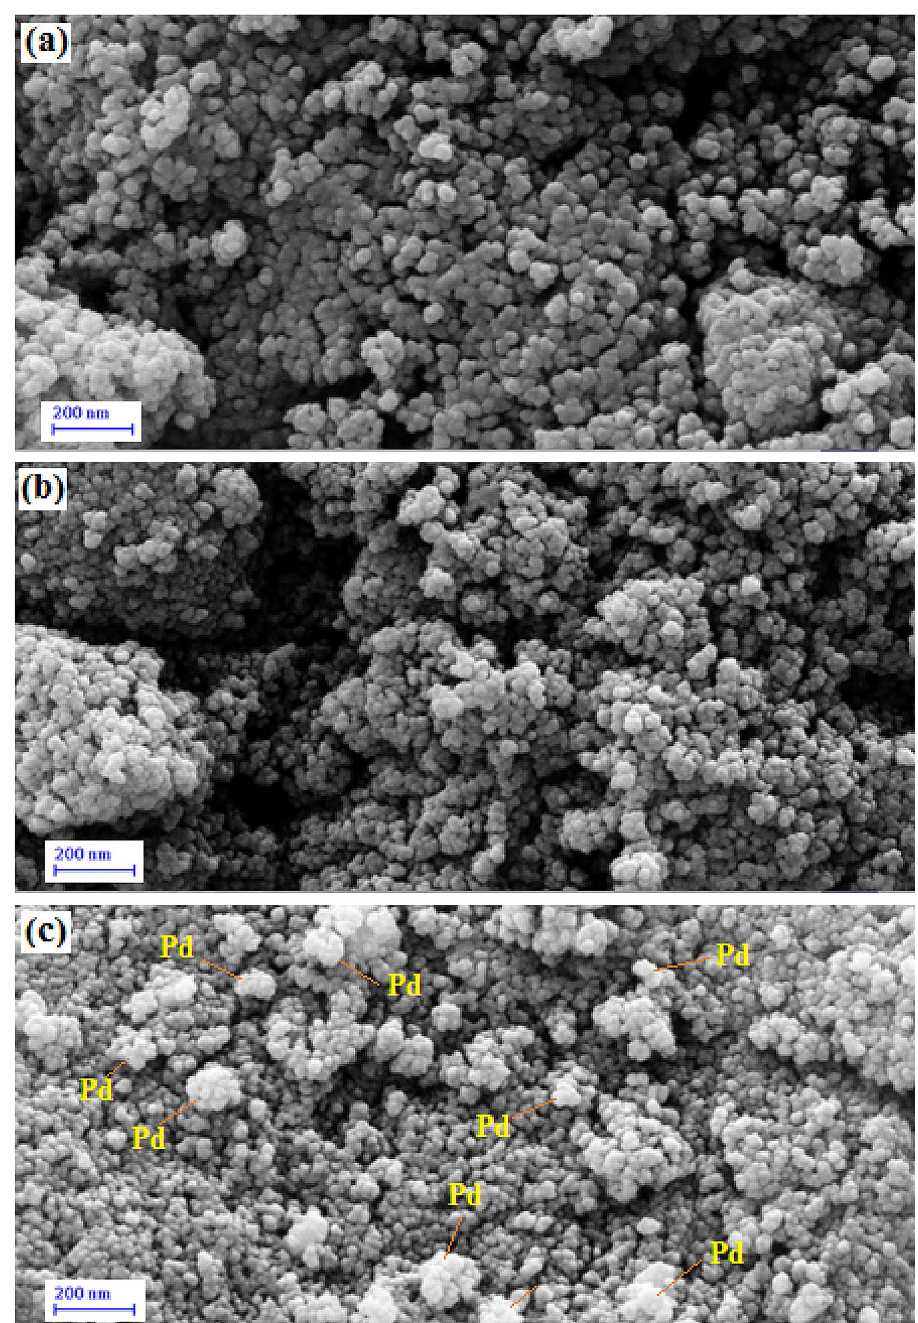
Figure 3. FE-SEM images of the ( a ) Fe 3 O 4 NPs, ( b ) Fe 3 O 4 @ Fritillaria NPs, ( c ) Fe 3 O 4 @ Fritillaria